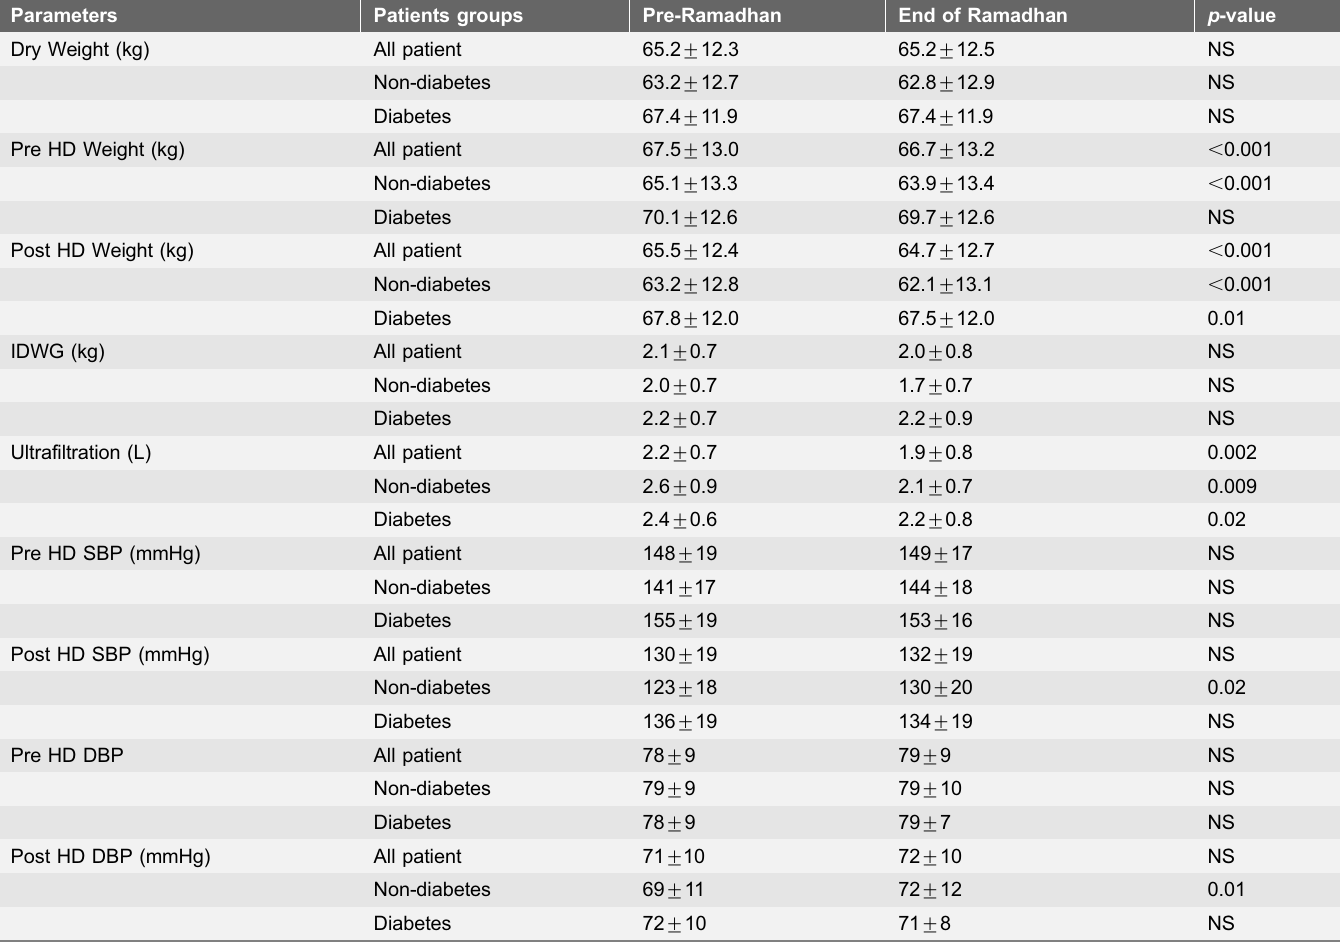
Table 2. Dialysis parameters pre- and end Ramadan fasting in haemodialysis patients (mean ¡ SD) and the p -values of changes (End Ramadan- pre- Ramadan values).